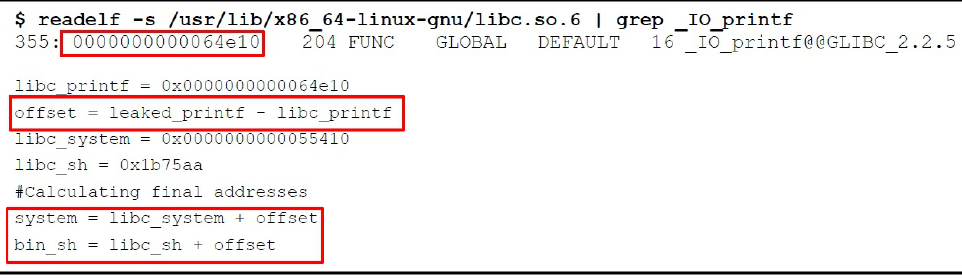
Figure 27. printf in libc using